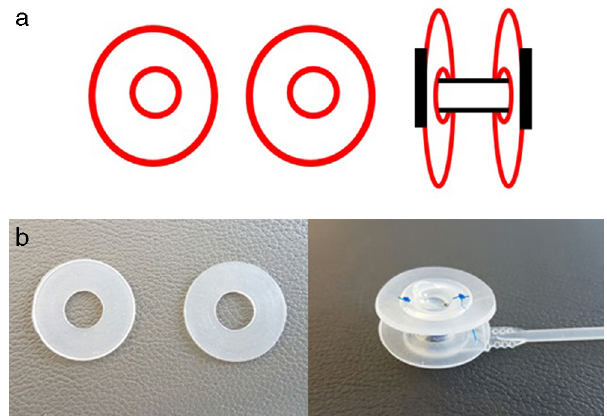
Figure 1 (a) Schematization of expanded voice prosthesis with silicone rings. (b) Silicone rings and prepared expanded voice prosthesis.